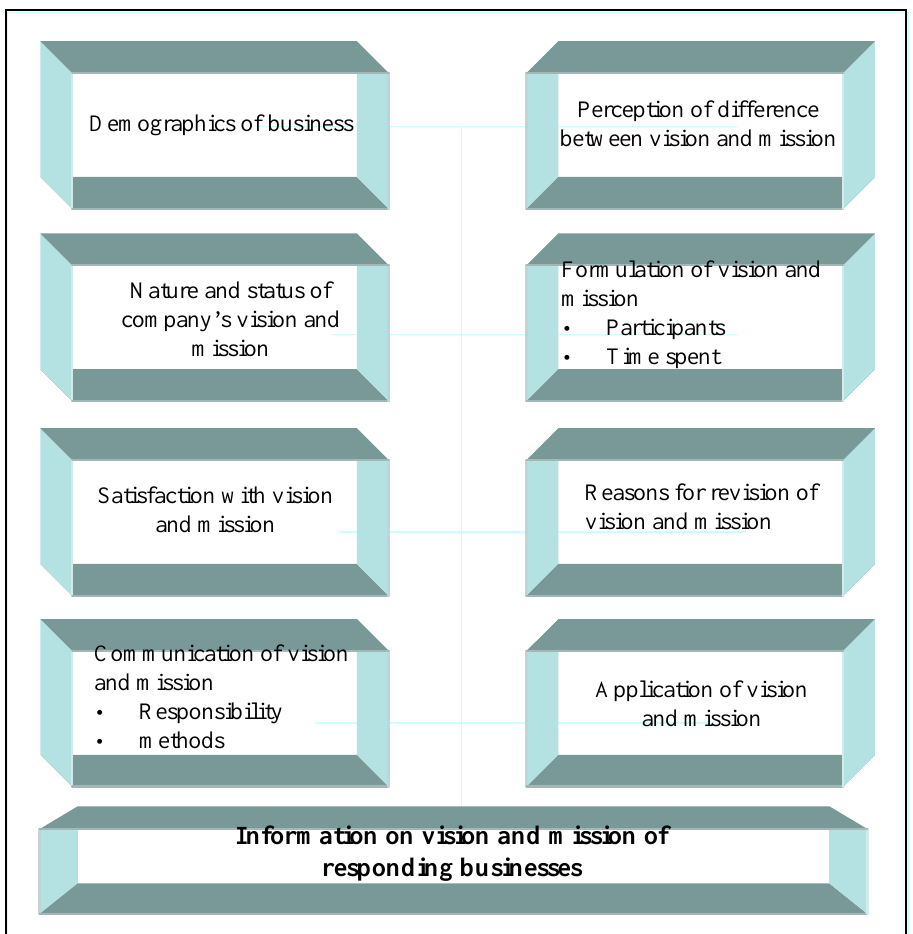
Nature and status